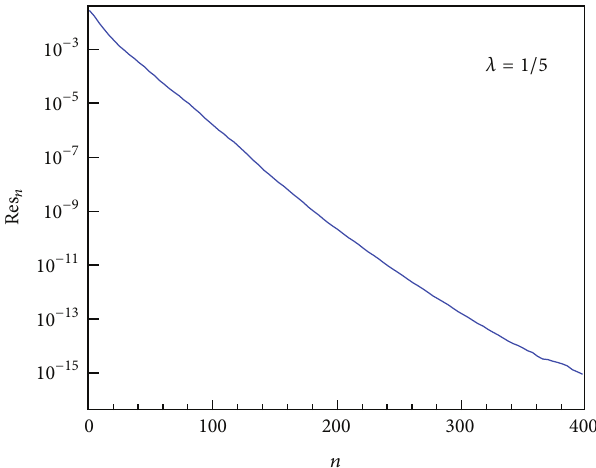
Figure 1: The convergence history of Res 𝑛 ( 𝜆 = 1/5 ).